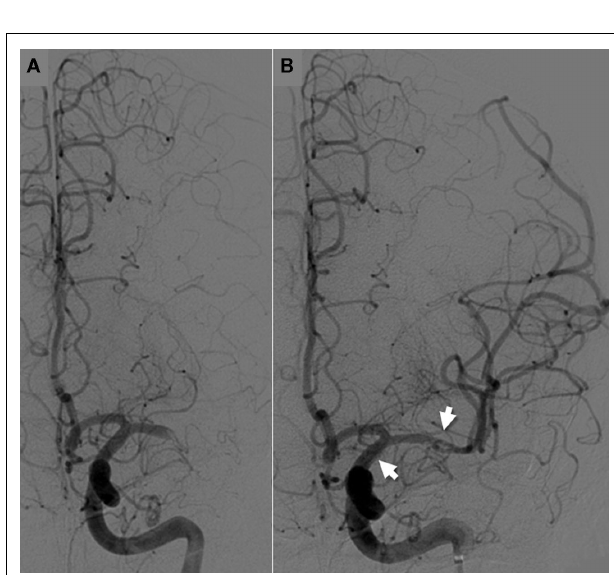
FIGURE 2 | Cerebral angiogram shows a left MCA-M1 occlusion (A), which was successfully recanalized with deployment of a self-expandable stent (B). Intraarterial infusion of tissue plasminogen activator (25MG) and thrombectomy with the Concentric Merci Retriever failed to recanalize the occlusion. Arrows demonstrate the proximal and distal ends of the stent.